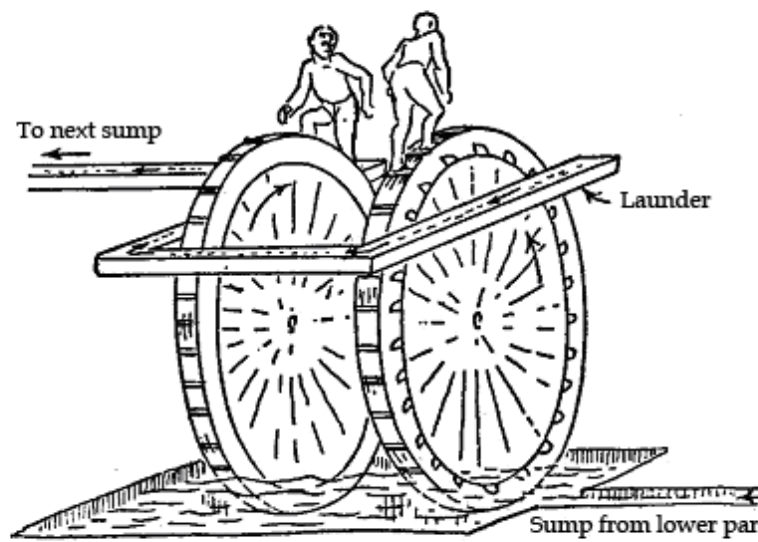
Figure 4. Waterwheels with compartments rim ; representation based on